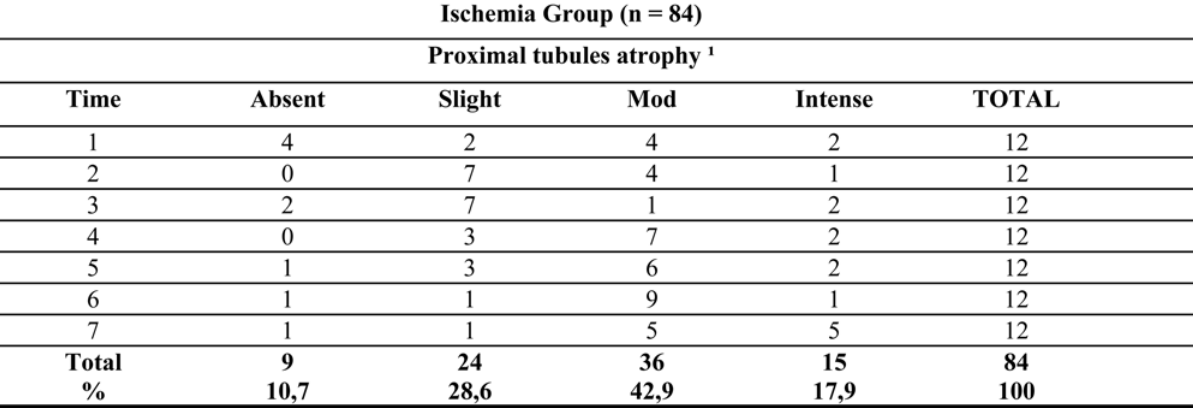
TABLE 4 - Proximal tubules atrophy score in the ischemia group (n=84).